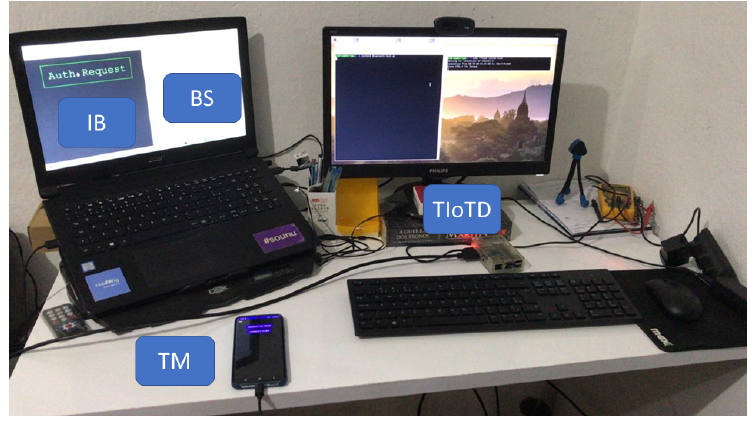
Figure 9. Testbed for trusted IoT device proof of concept.